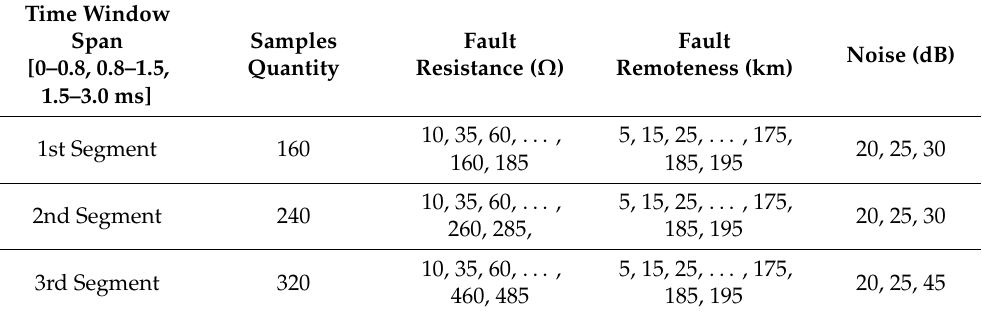
Table 3. Case studies for internal faults in testing data.